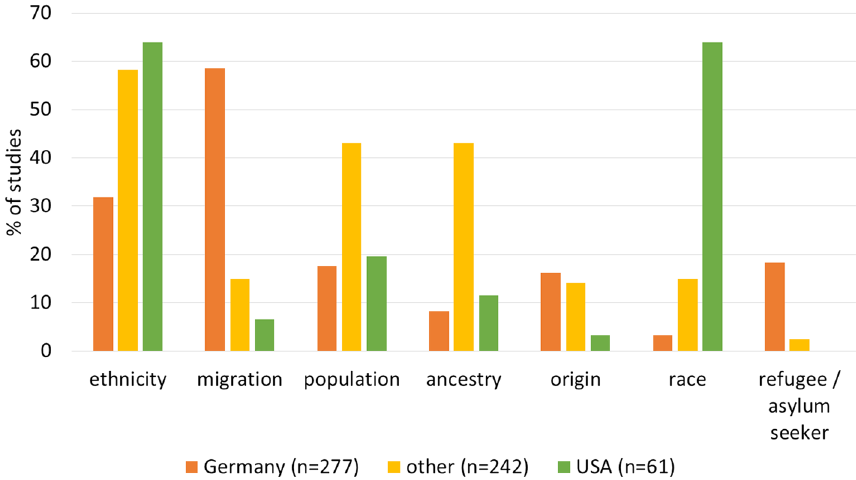
Fig. 3 Frequency of classifica- tion terms used in